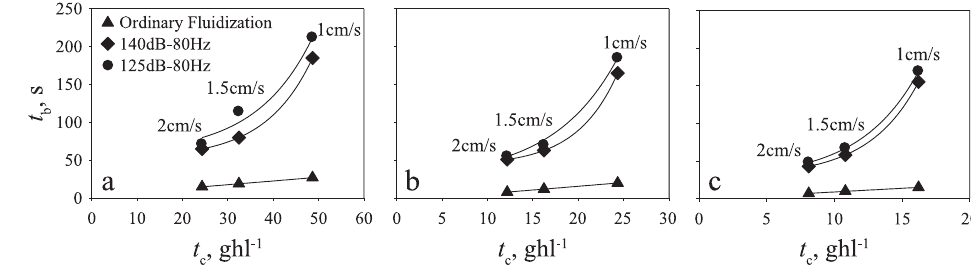
Fig. 19 Breakthrough time as a function of contact time (u ranging from 2 to 1 cm/s) under ordinary and sound-assisted conditions. (a) C 0 = 5 %vol.; (b) C 0 = 10 %vol.; (c) C 0 = 15